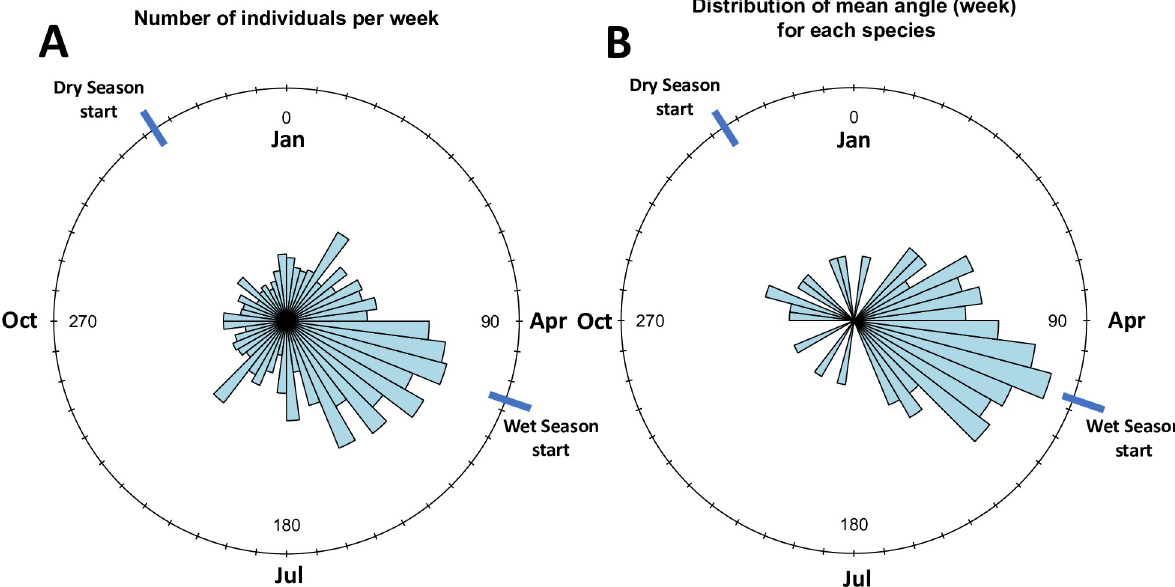
Fig 2. Circular statistics results. Average male abundance across the year (A) and mean angle of male flights for different ant species (B). Circles are divided into 48 bins, so each weak correspond broadly with one bin, and each month corresponds broadly with four bins.